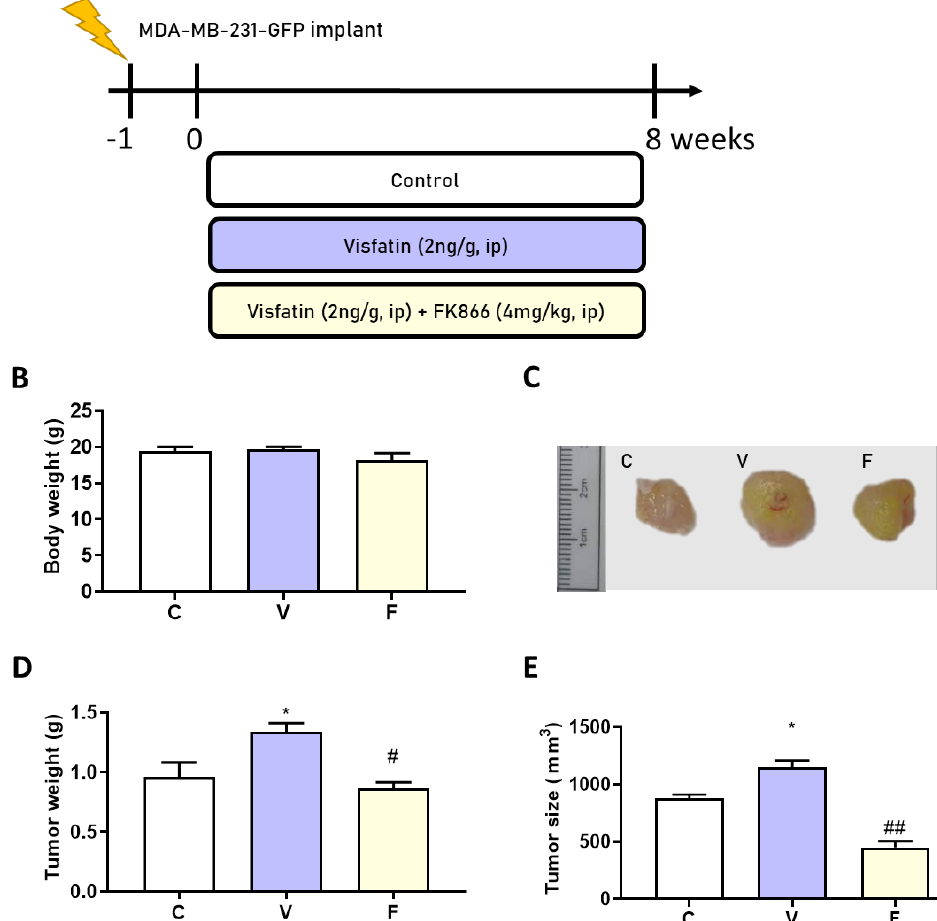
Figure 2. Effects of visfatin and its inhibitor FK866 on an MDA − MB − 231 − GFP xenograft animal model. ( A ) Flow chart of model induction. ( B ) Change in body weight. ( C ) Tumor morphology. ( D ) Tumor weight change and ( E ) tumor size change after 56 days’ treatment. Data are presented as mean ± SEM. C, control group. V, visfatin − induced group. F, visfatin + FK866 inhibitor group. * p < 0.05 compared to C. # p < 0.05 and ## p < 0.01 compared to V.